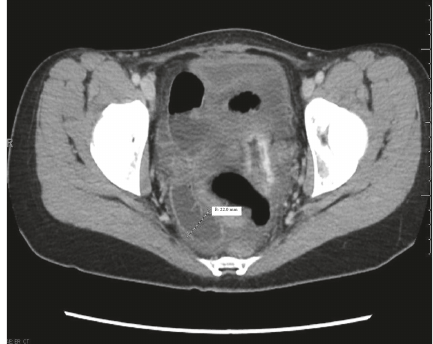
Figure 1: Axial CT image of the small bowel extending into the vagina. Normal thickness is less than